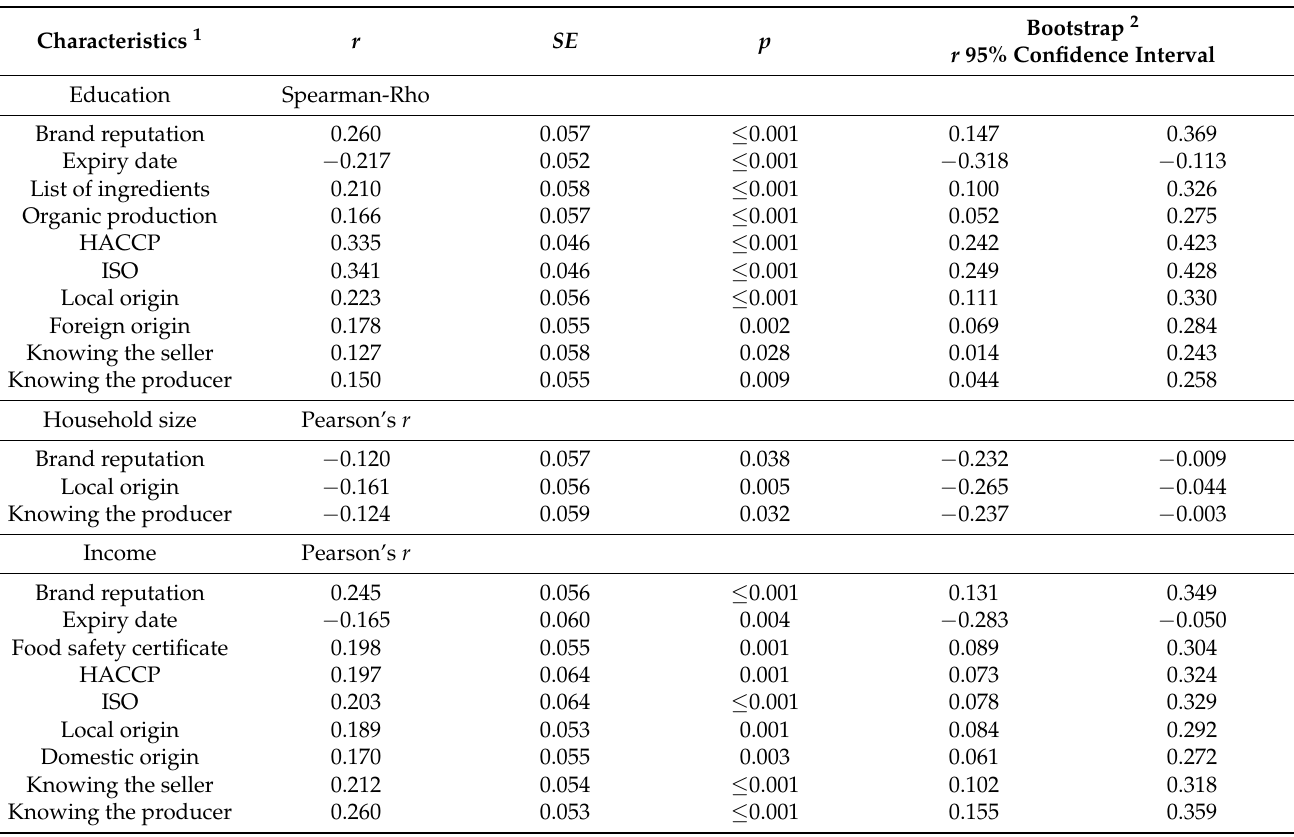
Table A2. Significant correlation coefficients for socio-demographic variables and rating of food safety and quality cues in Albania (Prishtina; n = 299); correlation coefficients including bootstrap